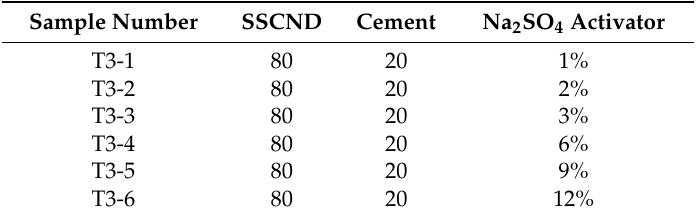
Table 4. Proportion of Na 2 SO 4 use for preparing the GCM (wt